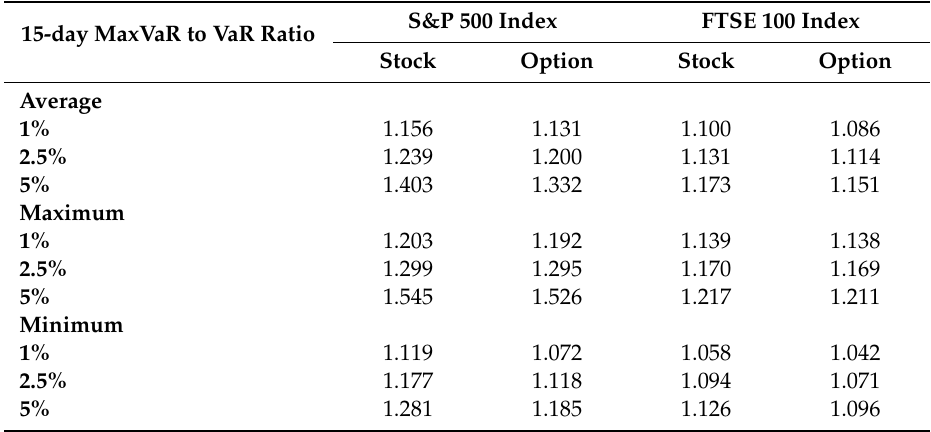
Table 9. Summary statistics for the 15-day inflation